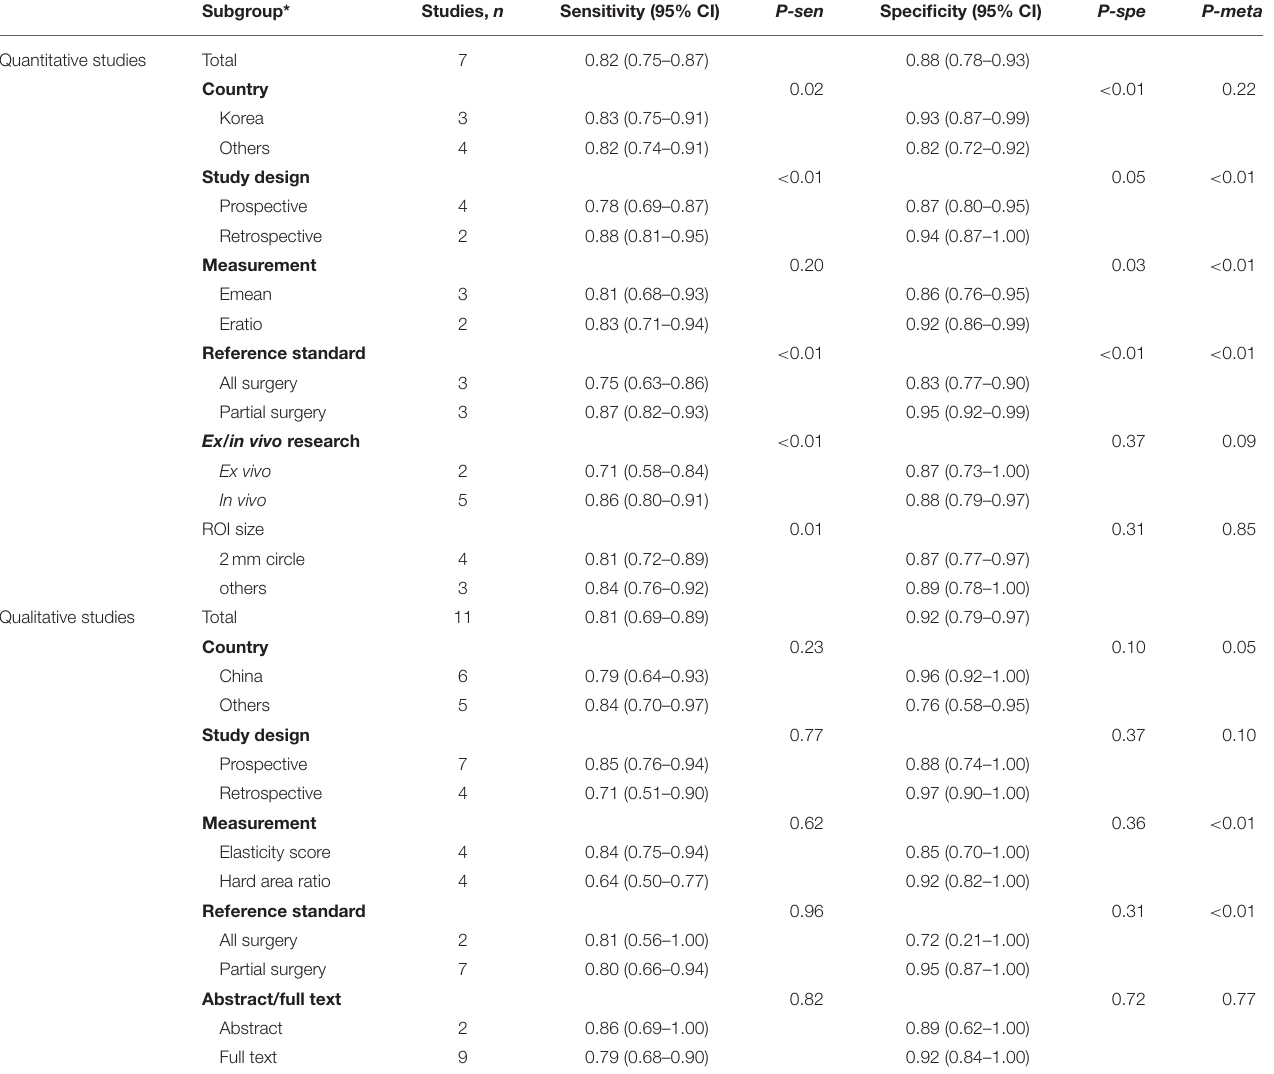
TABLE 3 | Subgroup analysis and meta-regression